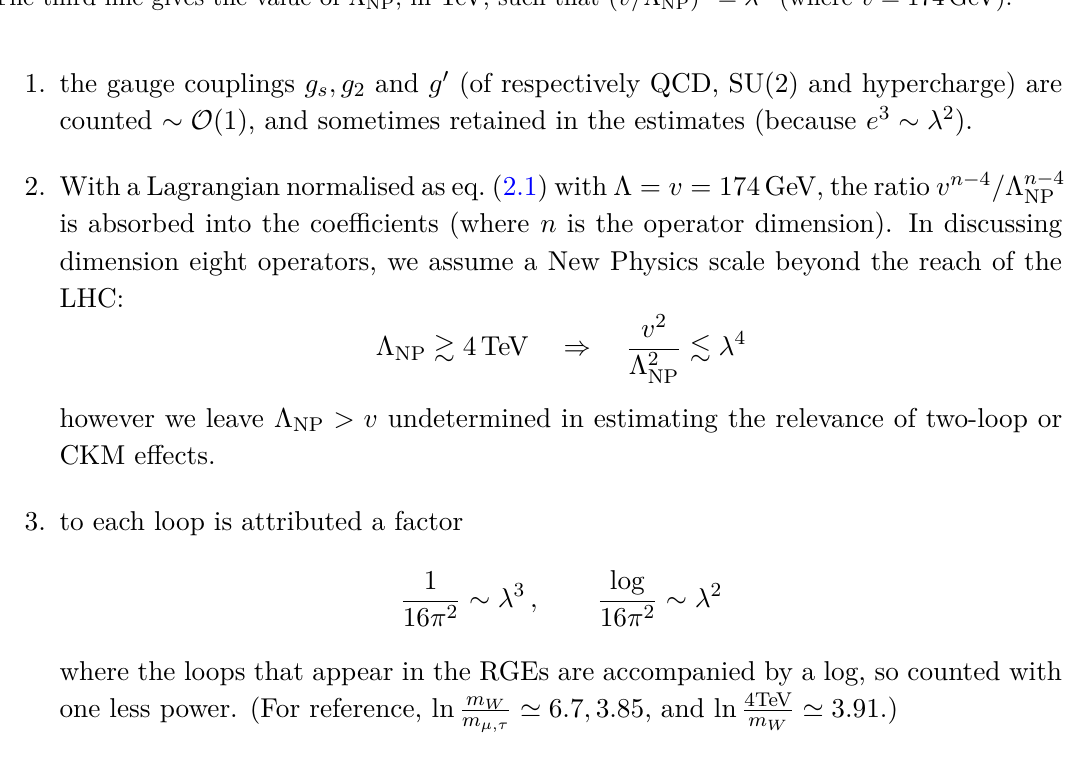
Table 1 . The second line gives the numerical value of λ k , for λ = 0 . 2 and k from the first line. The third line gives the value of Λ